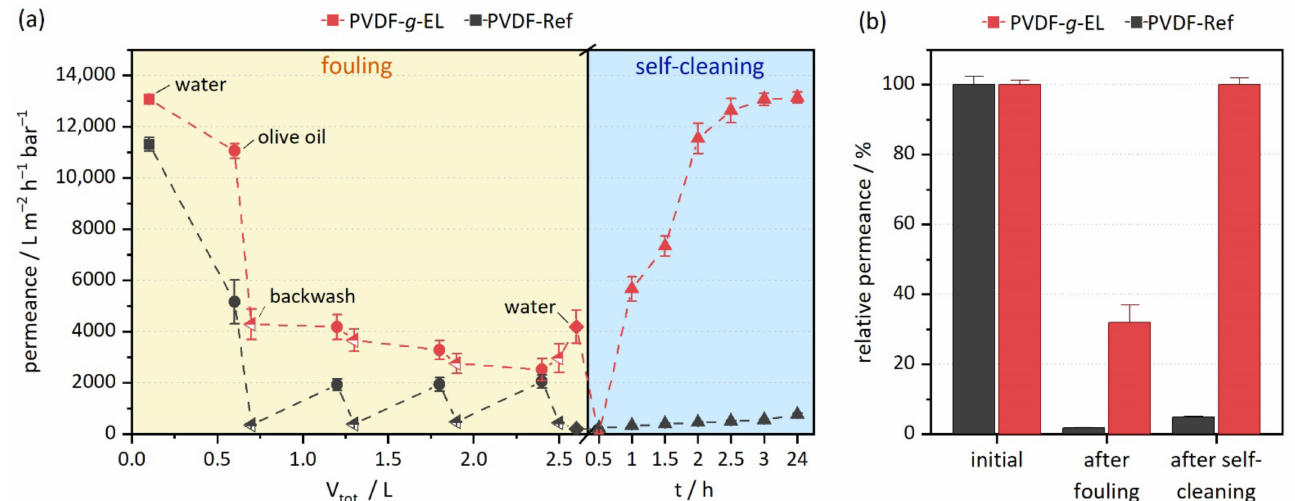
Figure 3. First fouling and self-cleaning cycle for PVDF-Ref and lipolytic PVDF- g -EL. ( a ) Permeance curves as a function of total filtered volume, V tot , during the fouling cycle, and as a function of time, t , during the self-cleaning cycle; ( b ) relative permeance P/P 0 at the beginning, after fouling, and after self-cleaning.